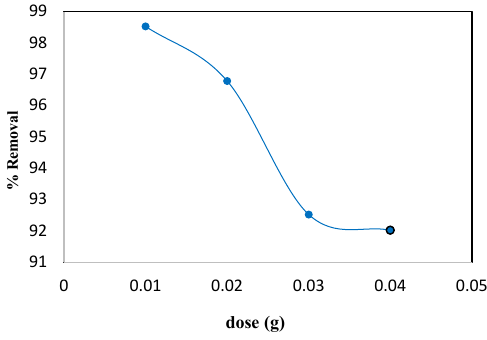
Fig. 5. Effect of adsorbent dose for the percentage removal of iron (III) ions by CuO NPs.